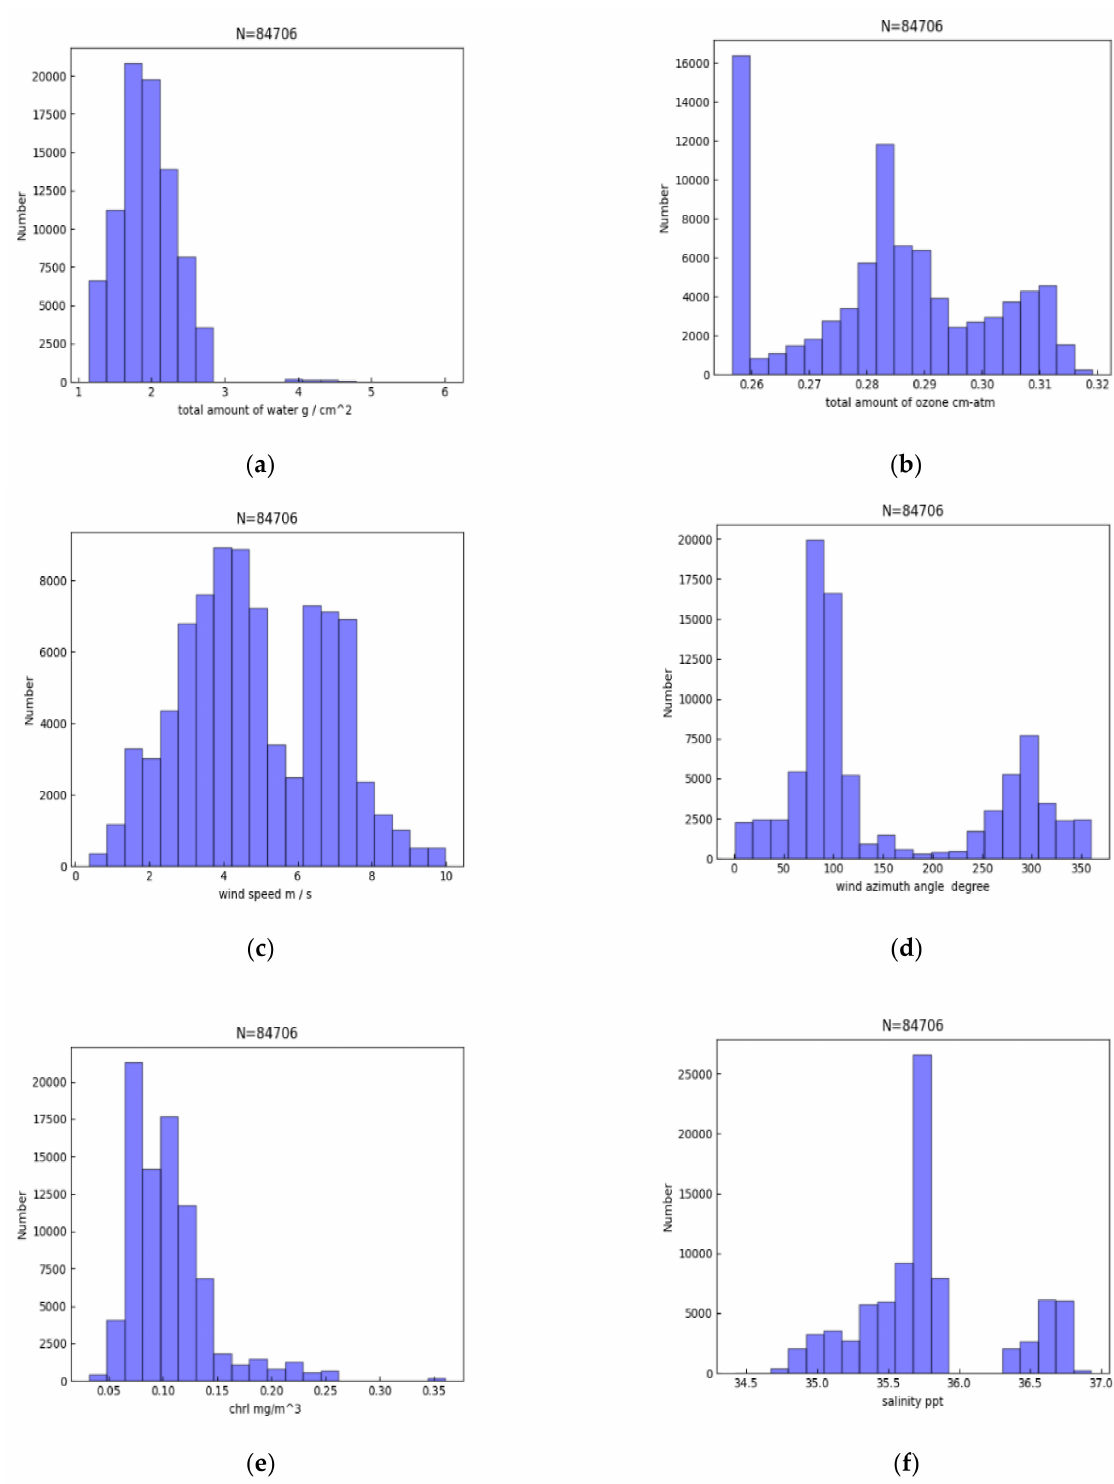
Figure 9. Environmental statistics over an SNES: ( a ) total amount of water; ( b ) total amount of ozone; ( c ) wind speed; ( d ) wind azimuth angle; ( e ) chlorophyll concentration; ( f )